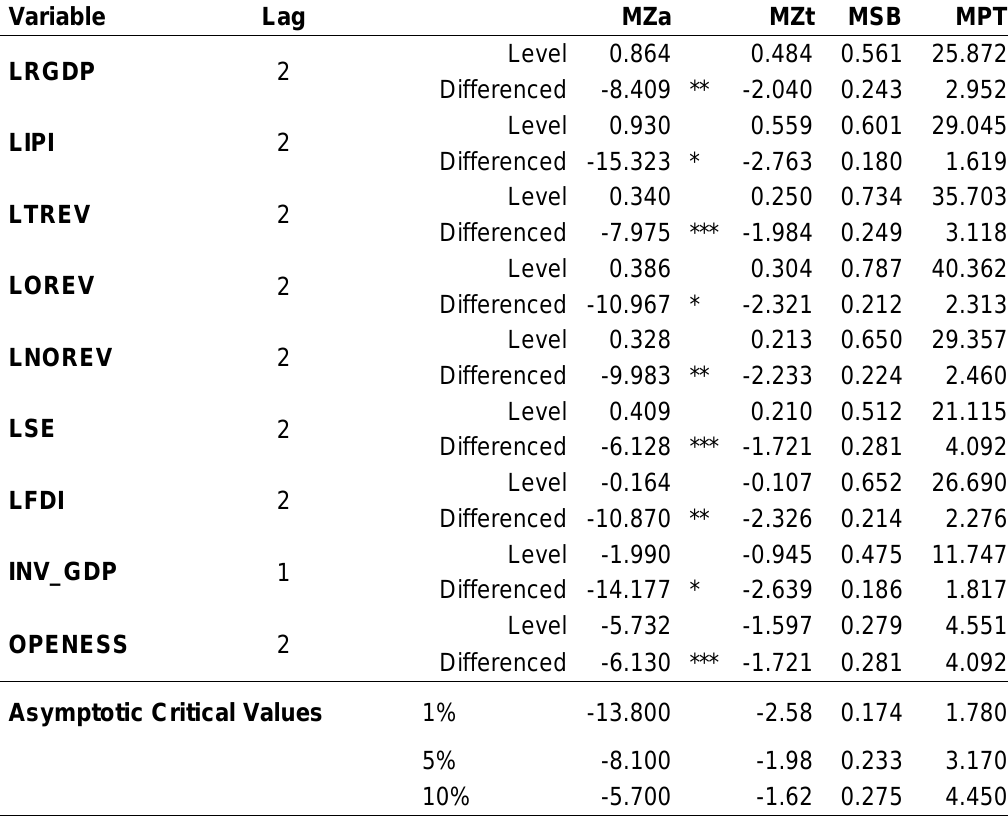
Table 2. Ng-Perron Unit Root Test